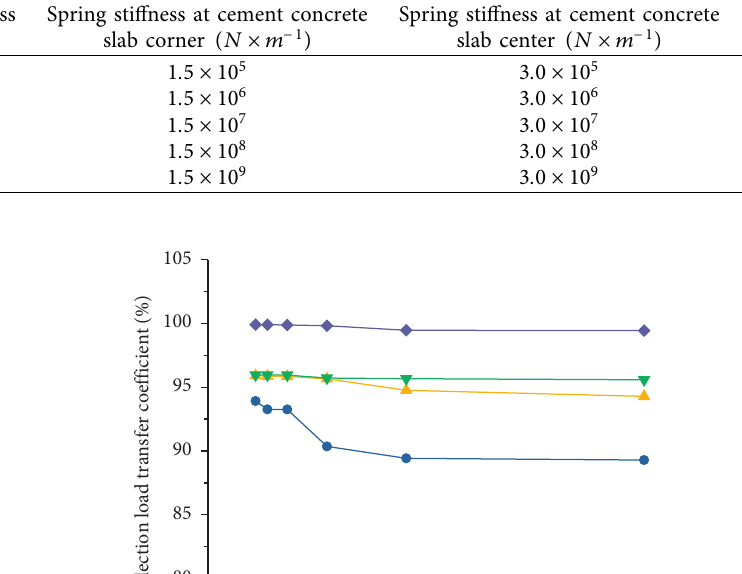
Table 3: Joint stiffness at different points of the slab.